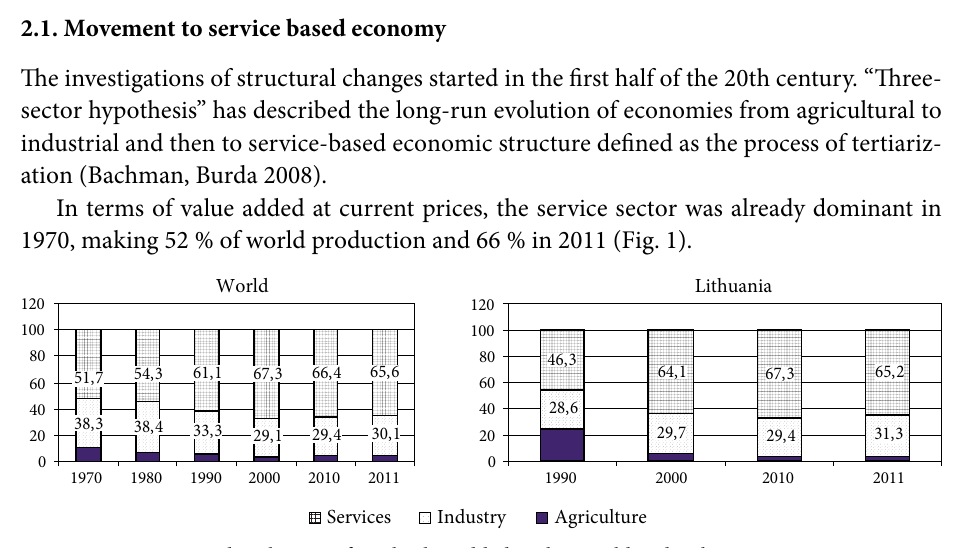
Fig. 1. Sectоr distributiоn оf tоtal value added in the Wоrld and Lithuania, in percent Sоurce: authоrs’ calculatiоns based оn the UN Statistics